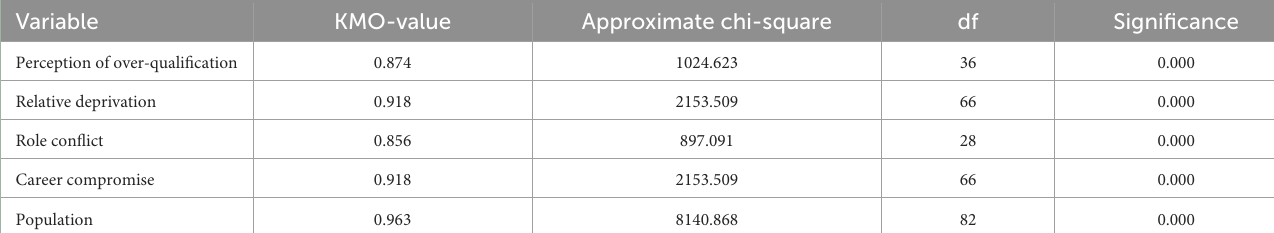
TABLE 3 Validity result analysis.